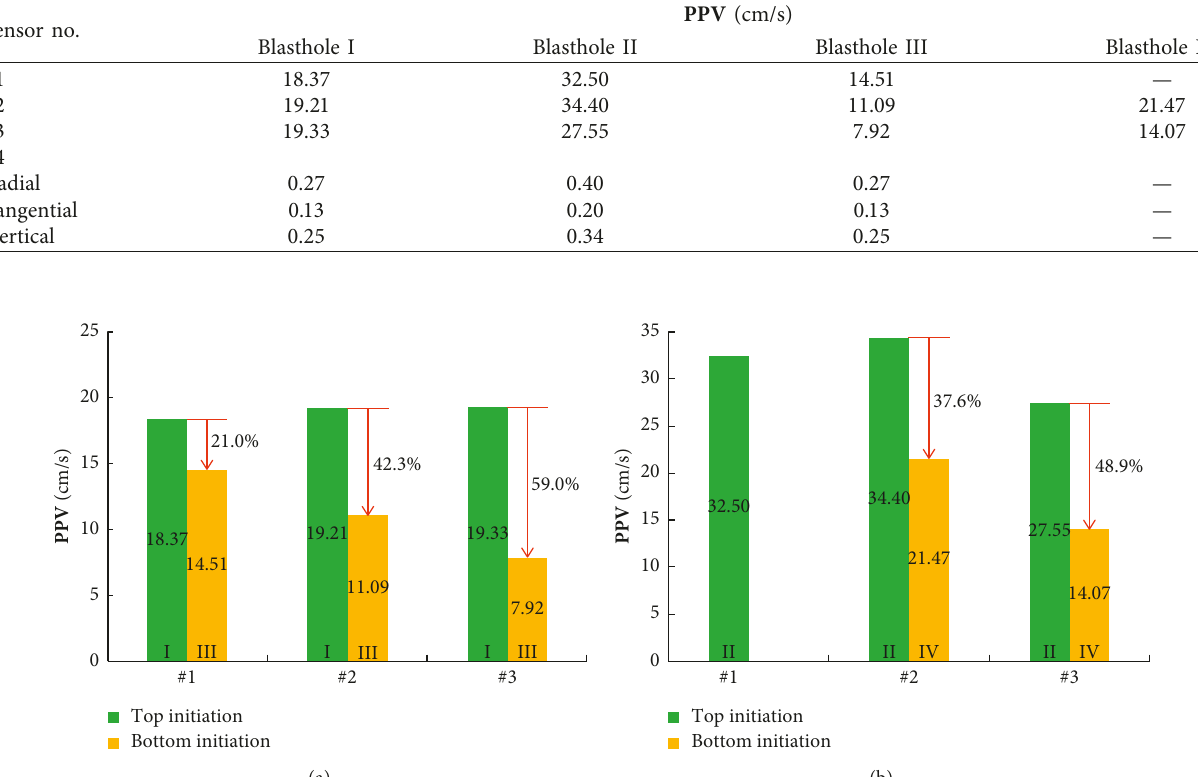
Figure 21: Comparison of PPV s measured below the blasthole bottom (#1 ∼ #3) in the single-hole blasting experiment. PPV s induced by blastholes (a) with shock wave-reflecting block and (b) without shock wave-reflecting